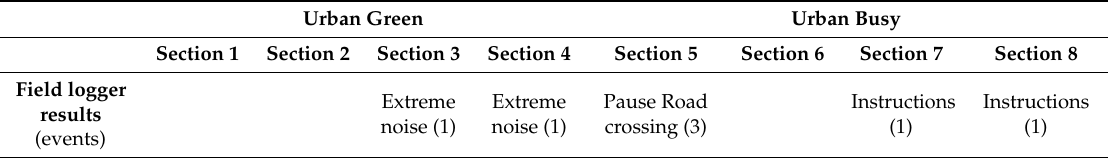
Table 4. Description of events occurring across the walks during the urban green to urban busy